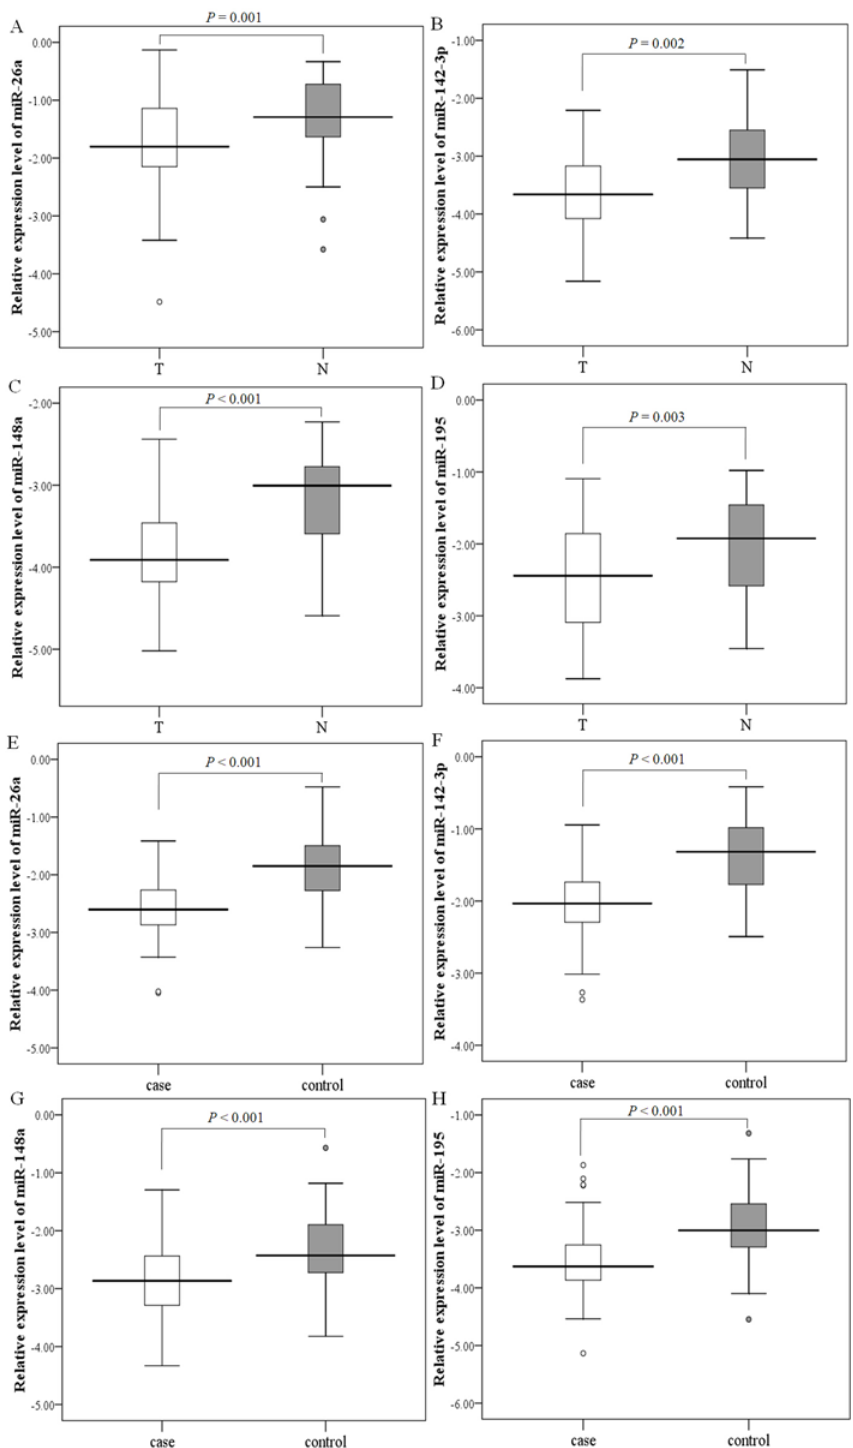
Fig 2. Box plots of relative expression levels of miRNAs by qRT-PCR in the training phases. (A-D) Relative expression levels of miR-26a, miR-142-3p, miR-148a, miR-195, in 50 paired gastric cancer tissues and corresponding noncancerous tissues (log 10 scale on Y -axis). (E-H) Plasma expression levels of miR- 26a, miR-142-3p, miR-148a, miR-195, in 80 GC patients and 80 healthy controls. The lines inside the boxes denote the medians (log 10 scale on Y -axis). The whiskers of box plots: Min to Max.